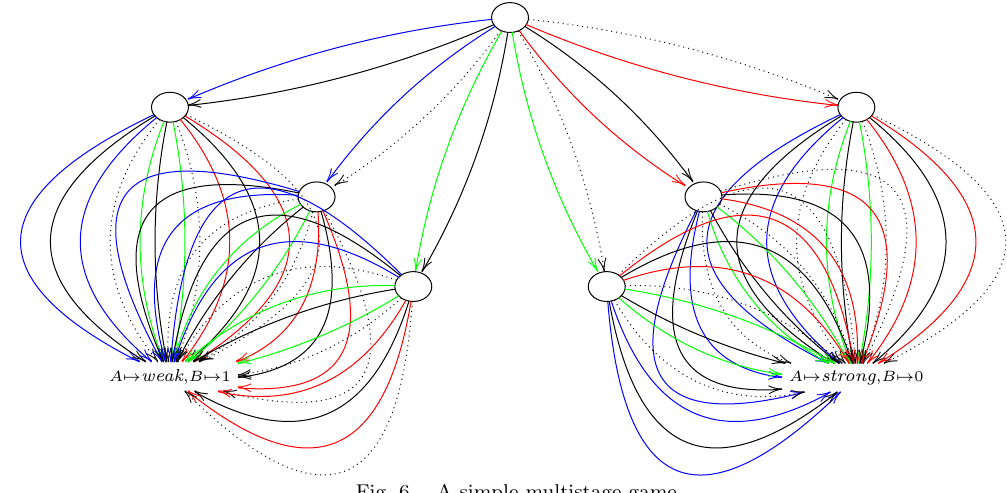
Fig. 6. A simple multistage